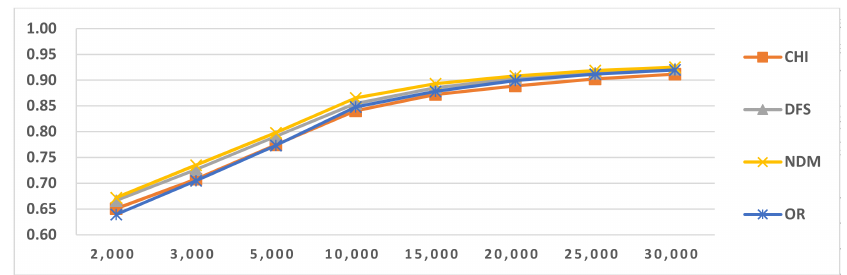
Figure 8. Results of LI in Latin script languages when select SVM and five-gram.